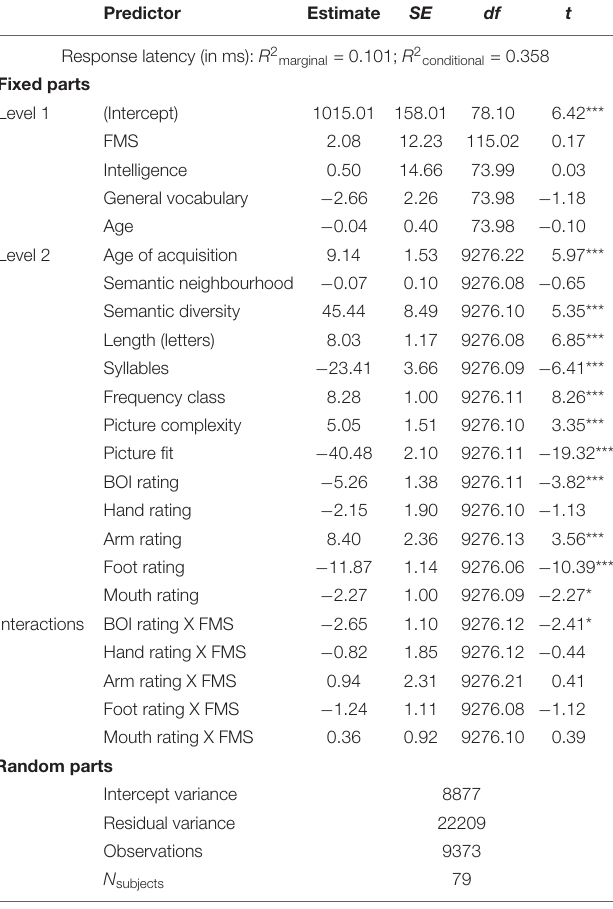
TABLE 5 | Mixed effects model predicting adults’ response latencies from fine TABLE 4 | Descriptive statistics for adult sample. motor skills, cognitive factors, age in months, word variables, BOI ratings, and M SD n Min Max body-part association